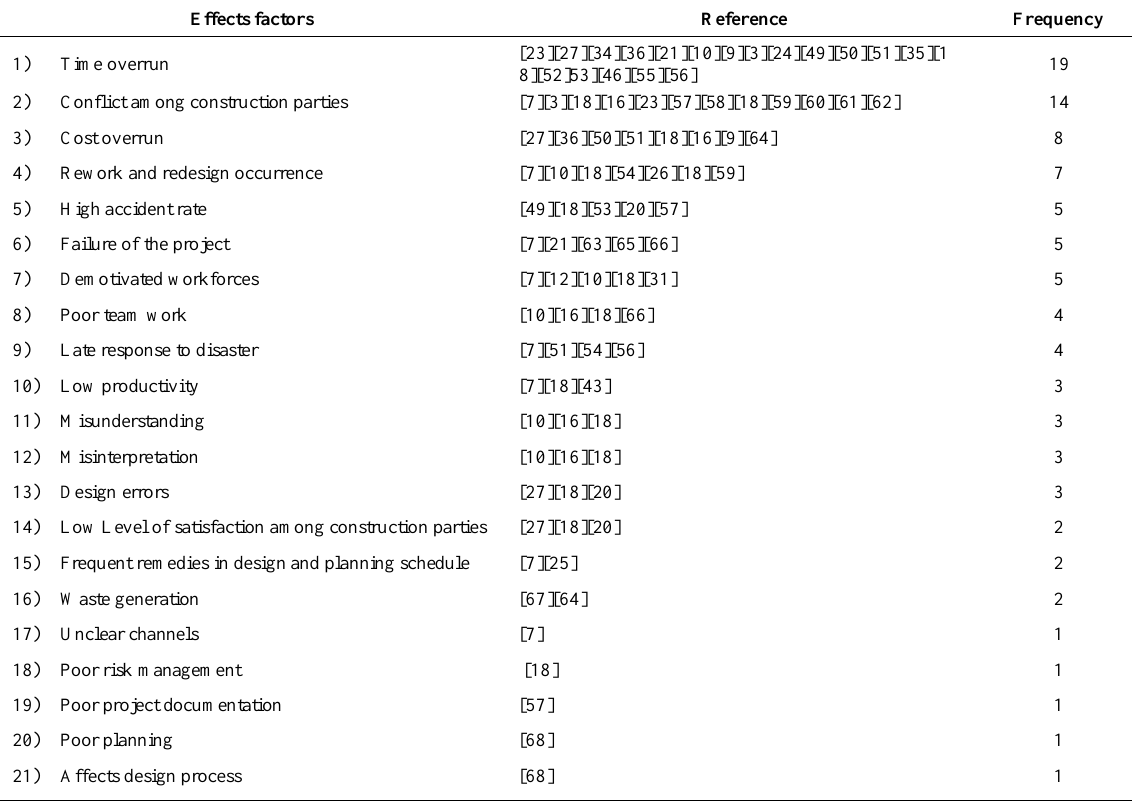
Table 3. Matrix of Effects Factors of Poor Communication and Their